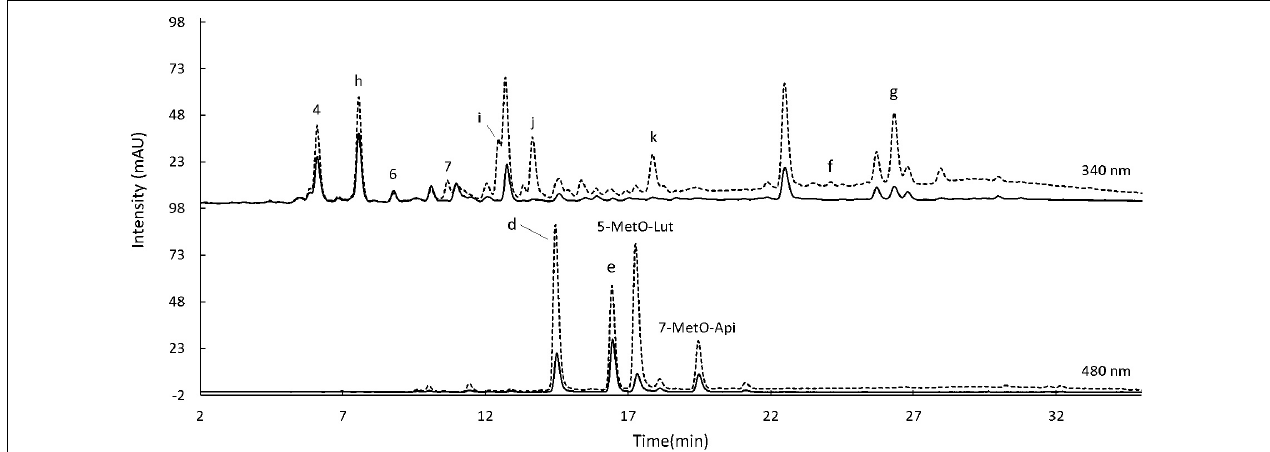
FIGURE 7 | HPLC chromatogram of flavonoids extracted from Kalatur (solid line) and Huggo (dash line) recorded at 340 nm (above) and 480 nm (below). 4: caffeic acid, 6: P -coumaric acid, 7: ferulic acid, d: luteolinidin-chloride, e: apigenidin-chloride; f: naringenin, g: apigenin, and h–k: unknown peaks, tentatively identified (see section “Discussion”). Injection volume: 10 µ l.